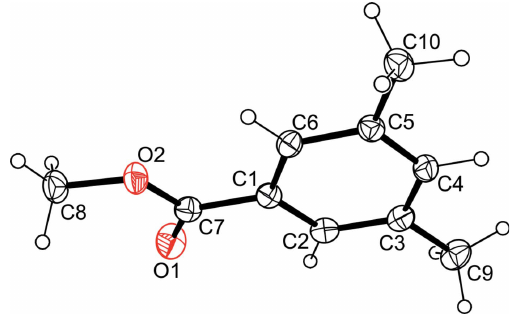
Figure 1 Perspective view of the molecular structure of 1 . Anisotropic displace- ment ellipsoids are drawn at the 50% probability level.